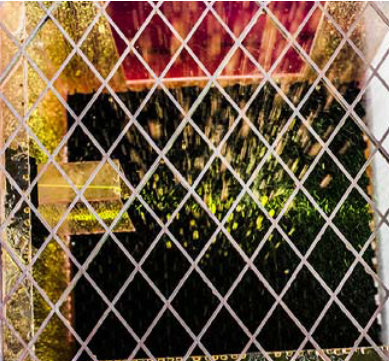
Fig. 7. The laser sheet with the water droplets saturated by Rhodamine G